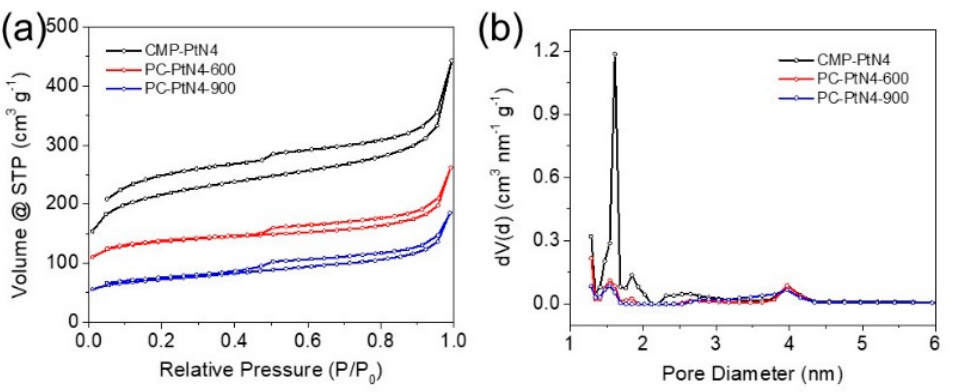
Figure 4. Nitrogen adsorption–desorption isotherms ( a ) and the corresponding pore size distributions ( b ) of CMP-PtN4, PC-PtN4-600 and PC-PtN4-900.